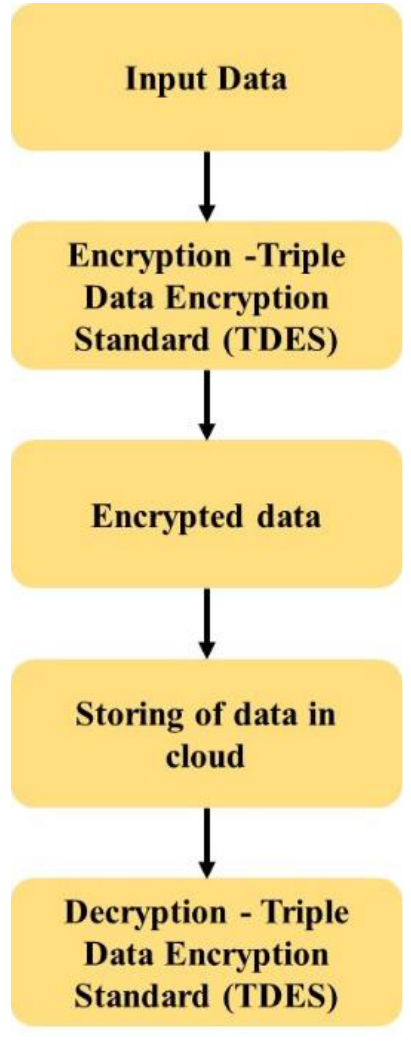
Figure 1. The TDES block diagram in encryption.